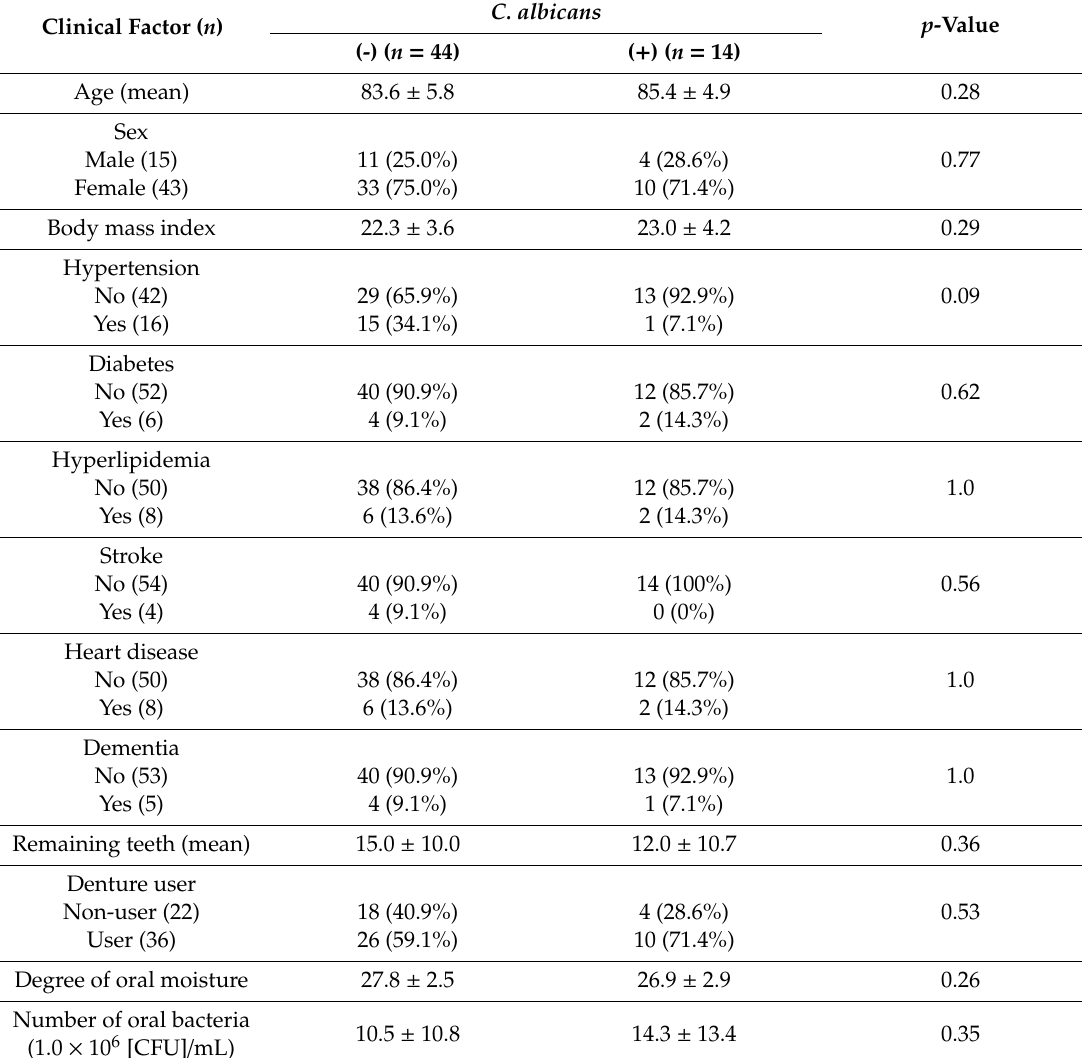
Table 5. Correlation between C. albicans detection and clinical factors among independent and dependent older people.